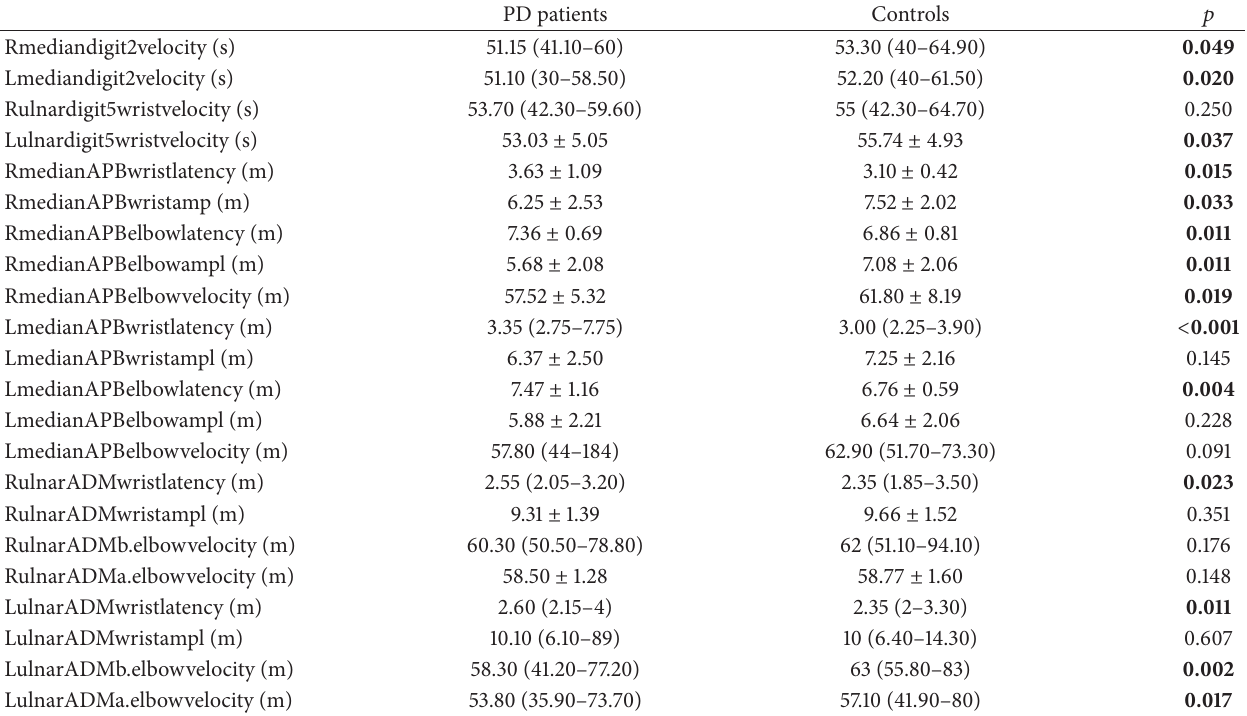
Table 3: The mean indices of electrophysiologic parameters between PD patients and controls.